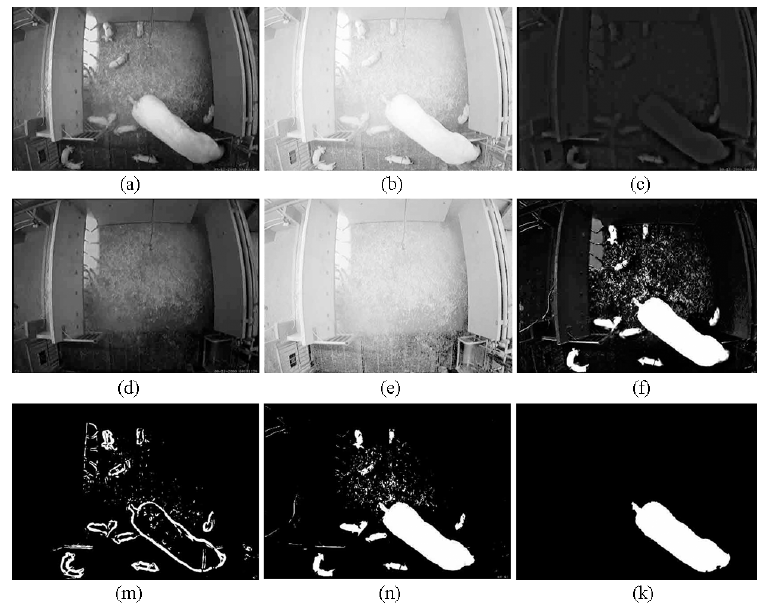
Figure 6. The general segmented result under light changes in the training data: ( a ) the current image; ( b ) the estimated illumination of the current image in logarithmic space; ( c ) the estimated reflectance of the current image in intensity space; ( d ) the reference image; ( e ) the estimated illumination of the reference image in logarithmic space; ( f ) the synthesized image; ( m ) the boundaries of the foreground objects; ( n ) the binary image after k -means on the synthesized image ( i.e. , image f); ( k ) the foreground object ( i.e ., the sow) is obtained by using the images m and n.